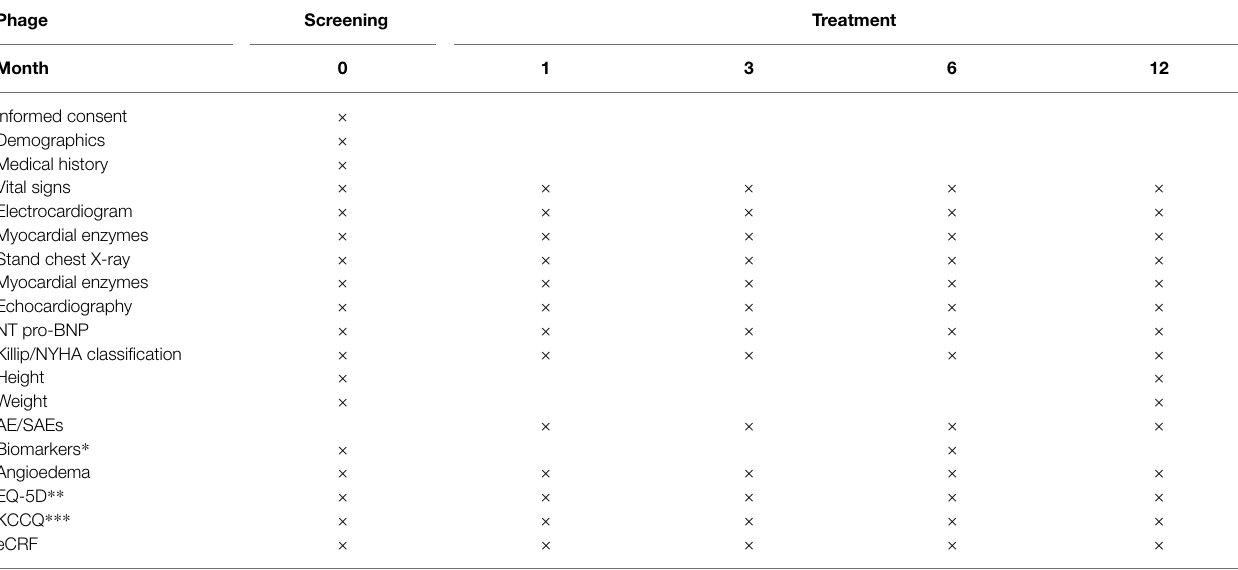
TABLE 2 | Data collection and schedule of